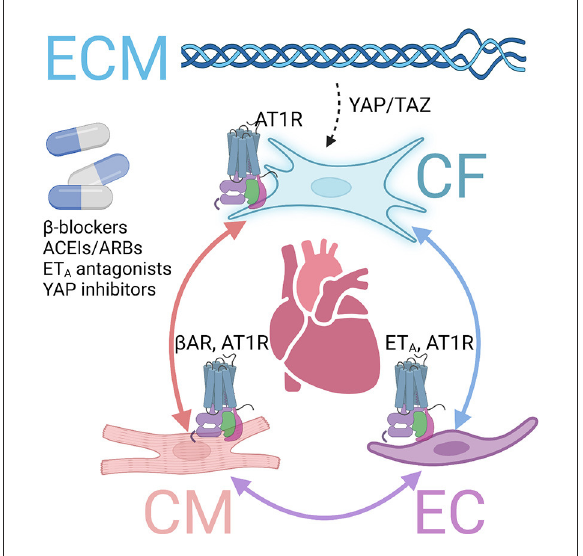
FIGURE2 GPCRs involved in fibrosis via crosstalk mechanisms. Several GPCRs contribute to cardiac fibrosis via interactions among cardiomyocytes (CMs), endothelial cells (ECs), cardiac fibroblasts (CFs), and extracellular matrix (ECM). Inhibiting those and inhibiting those GPCRs or downstream pathways